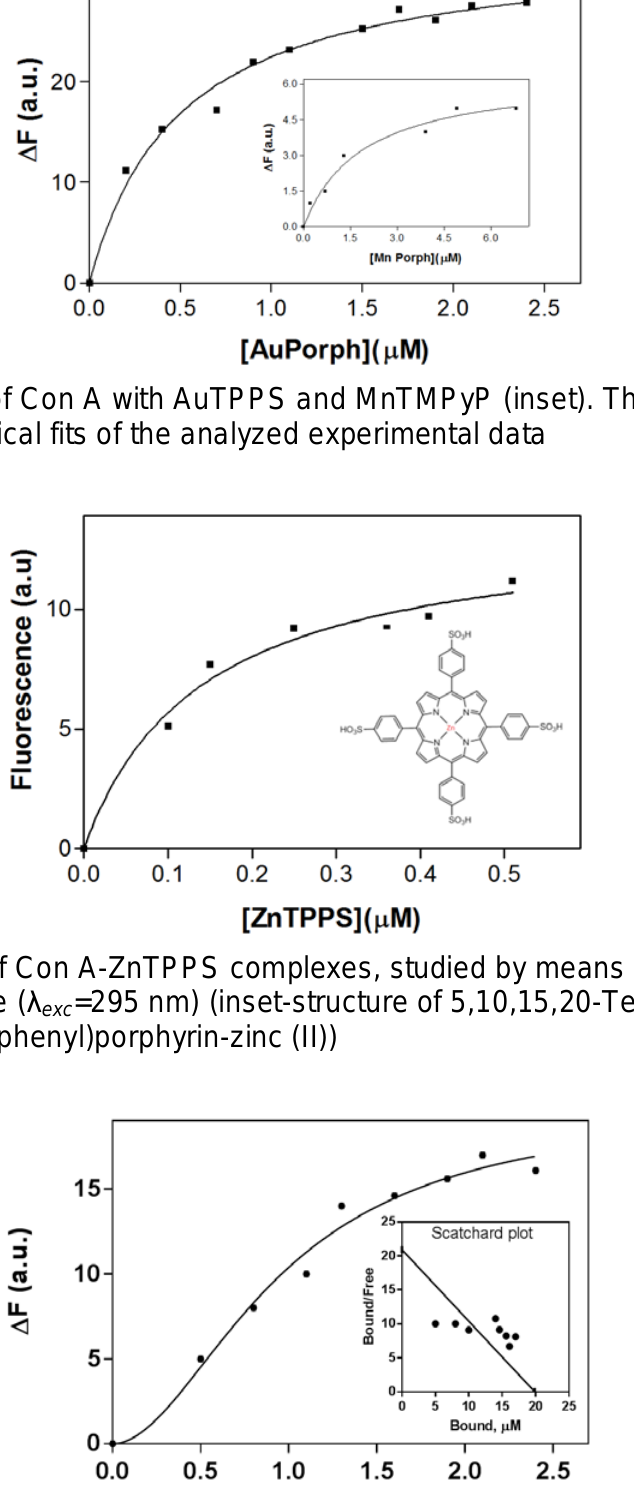
Sci Pharm. 2014; 82: 825–834